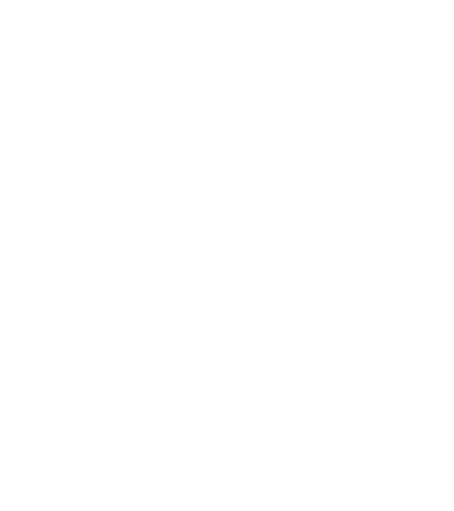
Figure 2. Boundary conditions used in the